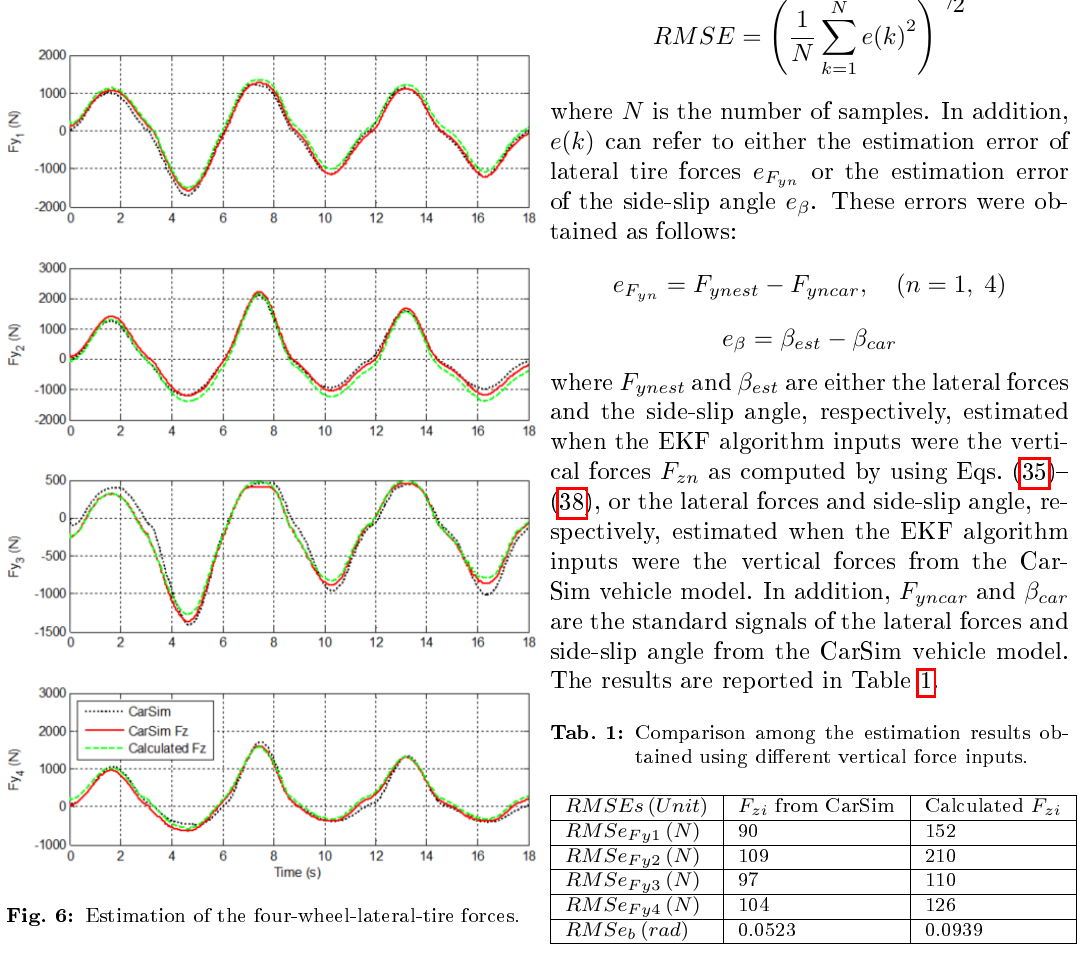
Figs. 6(cid:21)8 and Fig. 10 present the results of the simulation with road and driving conditions for which the tire(cid:21)road frictional coe(cid:30)cient was 0.85 and vehicle longitudinal velocity was 100 km/h. In all the simulations, using the estima- tor with vertical-force inputs directly obtained from the CarSim vehicle model yielded the op- timal estimation results. The RMSE values for all estimations (Table 1) indicated that using the EKF algorithm inputs from the CarSim vehicle model as vertical forces always resulted in a more favorable performance than did using the EKF algorithm inputs calculated using Eqs. (35)(cid:21)(38) as vertical forces. In particular, the RMSE val- ues were low when using vertical forces calcu- lated from Eqs. (35)(cid:21)(38) and lower when